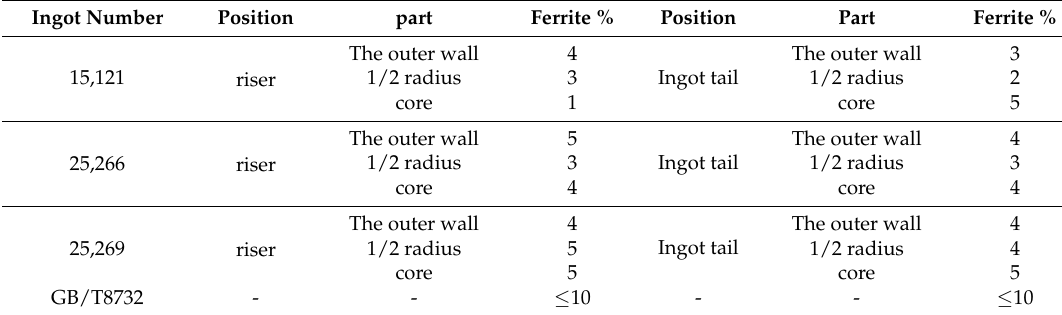
Table 5. Ferrite content detected in 0Cr17Ni4Cu4Nb steel material.